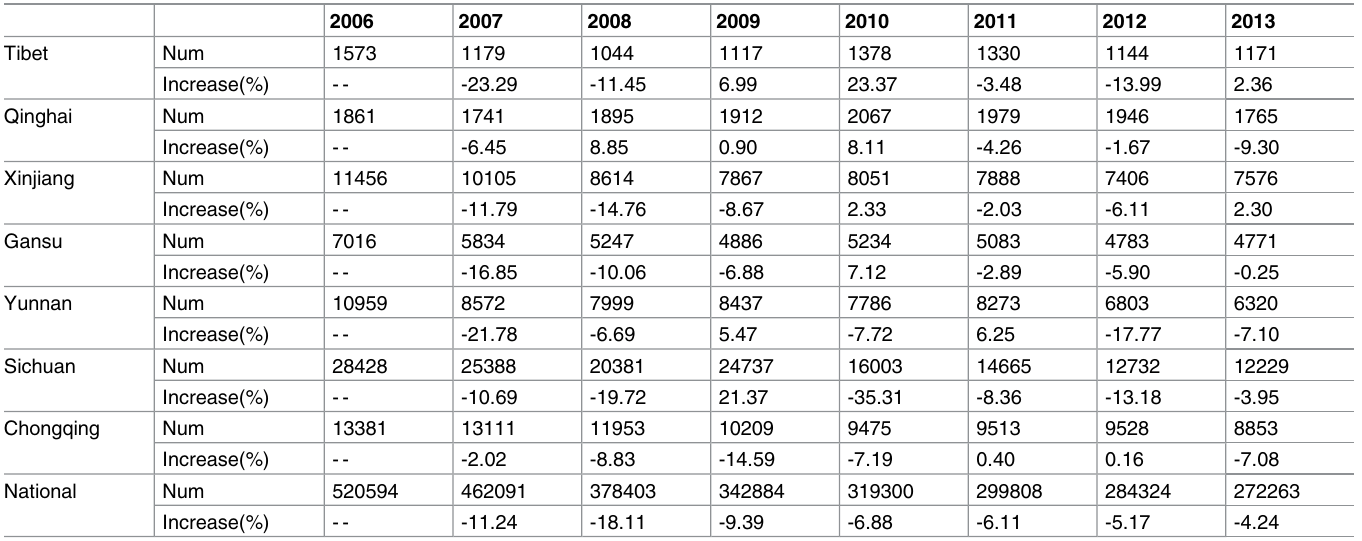
Table 6. Casualties caused by the accidents from 2006 to 2013in high-altitude provinces and nationally in China.